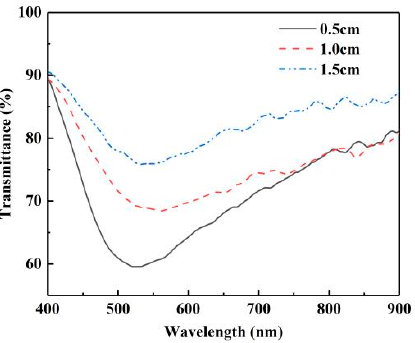
Figure 7. Normalized transmission spectrum for different lengths of MSF.